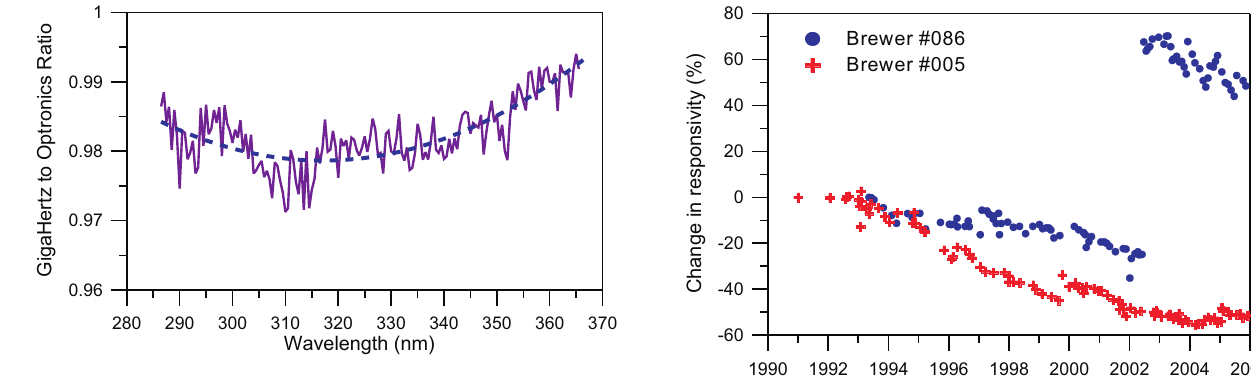
Fig. 1. The GigaHertz to Optronics irradiance scale ratio, as de- termined in 2002, when two new spectral irradiance lamps were obtained from each laboratory. The dashed line is the 2nd degree polynomial fit of the ratio.